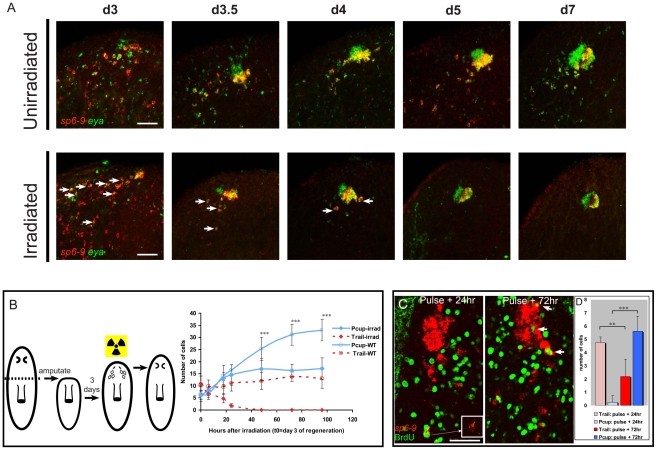
Optic cup trail cells are a source of new optic cup tissue.All fluorescent images are FISH, except for fluorescent detection of BrdU by antibody. (A) Time course of eye regeneration in unirradiated animals and animals irradiated at day 3 of regeneration following decapitation. In irradiated panels arrows indicate double positive cells. (B) Experimental design diagram and quantification of cell numbers in pigment cups (Pcups) and trails of irradiated and unirradiated animals over time (mean ± s.d; n≥9 eyes/trails; significance by two-tailed t-test is shown for the Pcup cell numbers in irradiated vs. un-irradiated ***P<.05). (C) BrdU injection at day three of regeneration after decapitation only labels trail cells after one day, but labels Pcup cells after a longer time delay. Inset: magnification of sp6-9 signal in BrdU/sp6-9-positive cell. Arrowheads indicate sp6-9+/eya+/BrdU+ Pcup cells. (D) Quantification of BrdU+/sp6-9+/eya+ cell numbers in the trail and Pcup 24 h and 72 h after BrdU injection (mean ± s.d; n = 5 eyes; significance by two-tailed t-test ***P<.001, **P<.005). Scale bars, 50 µm.